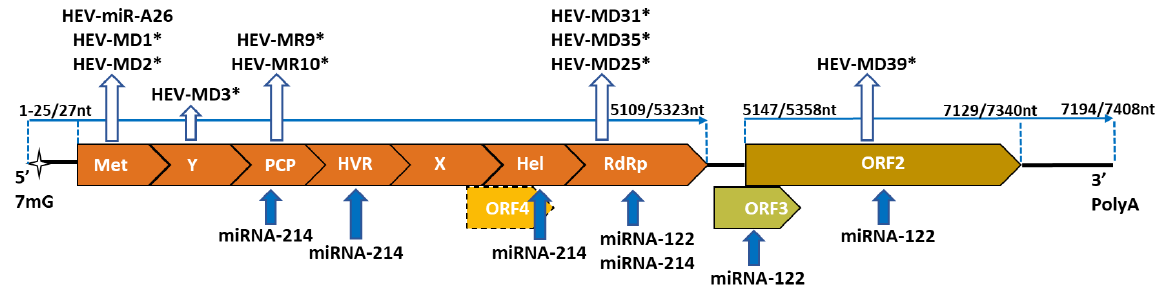
Figure 1. A schematic diagram of the target sites for host mi-RNAs and predicted encoded sequences for HEV-miRNAs. The HEV genome is approximately 7.2 kb and consists of three open reading frames ( ORFs ). ORF1 is the biggest and encodes nonstructural proteins. ORF2 is located ~30 nt. downstream from the stop codon of ORF1 and encodes viral structural proteins. ORF3 , which is encoded small phosphoprotein, is located ~20 nt downstream from the stop codon of ORF1 and overlaps ORF2 . The transient ORF4 is located within ORF1 and is represented by a dotted line [17]. Empty arrows represent sites encoding HEV-miRNAs, and full arrows, host miRNA binding sites. Asterisk (*) indicates in silico predicted HEV-miRNA coding domains. Indicated length in nucleotides (nt) is according to Tong H. et al. [23].